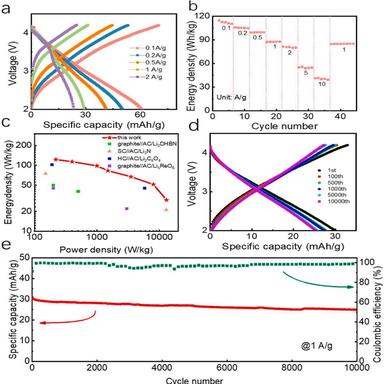
(a) GCD curves at various current densities of the prAC-1//graphite LIC; (b) rate capability of the prAC-1//graphite LIC between 2.0 and 4.2 V at different current densities of 0.1, 0.2, 0.5, 1, 2, 5, and 10 A/g; (c) electrochemical performance of the prAC-1//graphite LIC compared with previously reported LICs; (d) voltage profiles of prAC-1//graphite LIC after 1st, 100th, 500th, 1000th, 5000th, and 10000th cycles between 2.0 and 4.2 V; (e) cycle performance of the prAC-1// graphite LIC at a current density